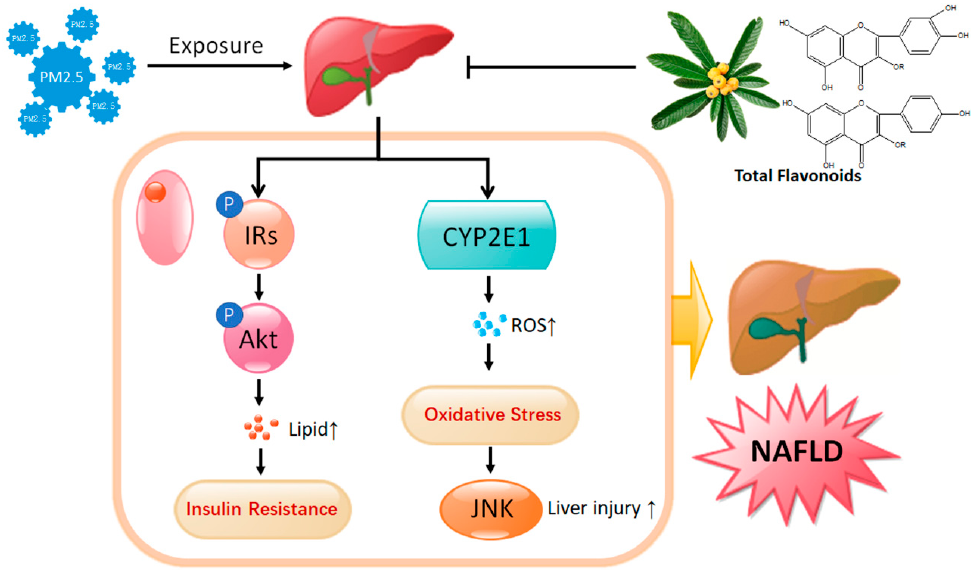
Figure 6. A schematic illustration of how TF extracted from Loquat Leaf interfered with IR and oxidative stress in PM 2.5 -induced NAFLD. “ ↑ ” indicates increase.